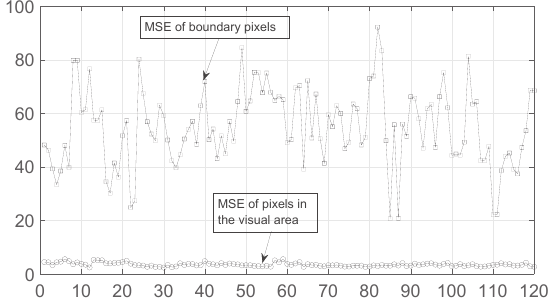
Fig. 4. The mean square error value of the pixels in the boundary and those in the visual region of 120 endoscopic images for standard JPEG image compression algorithm with a quantizer value of